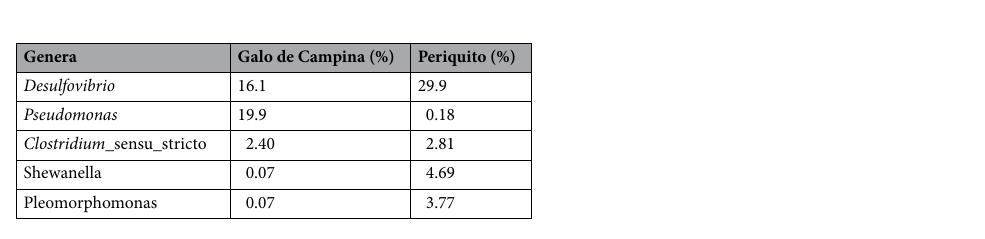
Table 2. Most abundant genera found in Galo de Campina e Periquito oilfield. *Unclassified genera from Galo de Campina is 11,1% and Periquito 7,62.